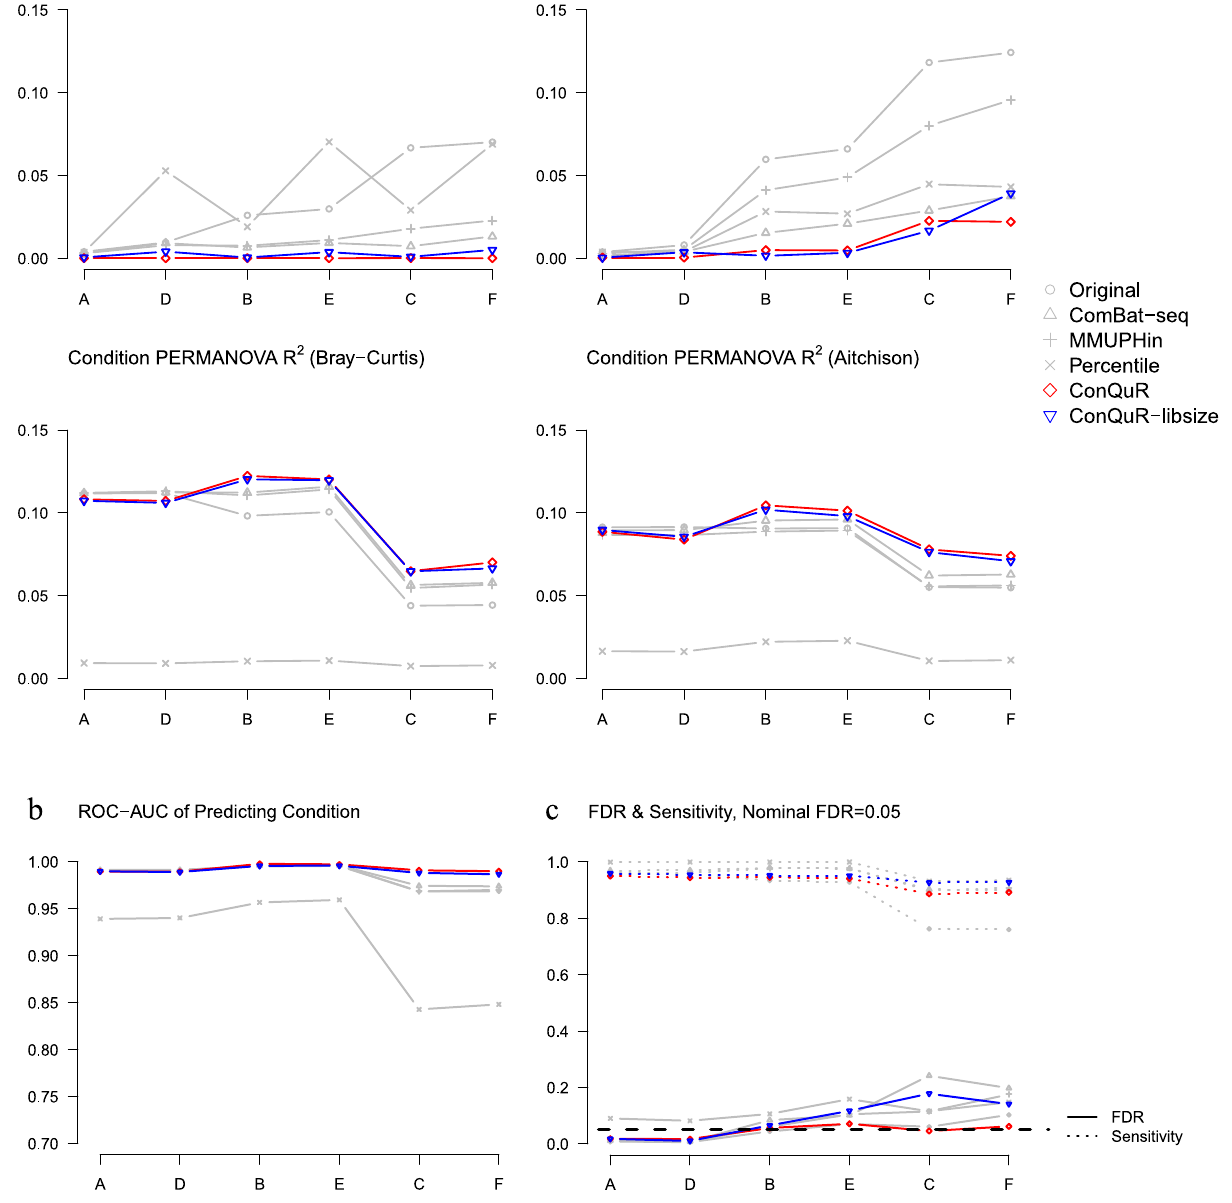
Fig. 2 |Evaluationonthesimulateddata. Thereare6 simulationscenarios with2 corresponding method are shown on the right within the graph. a Average pro- conditions and 2 batches, based on the starting data processed from the MOMS-PI portions of data variability explained by Batch and Condition, quanti fi ed by study. Simulation scenarios are: A. Condition FC=16, Batch FC=1 (Null), B. Con- dition FC=64, Batch FC=4 (Condition Effect>Batch Effect), C. Condition FC=4, Batch FC=64 (Condition Effect<Batch Effect), where Condition and Batch are simulated from joint Bernoulli distribution with p Condition =0.5, p Batch =0.5, and OR=1.25; Scenarios D, E, F are similar to Scenarios A, B, C, respectively, but , making batchvariability incorporate librarysize variability. In p Batch = 1 1+exp (cid:1) libsize s ð Þ thefollowingplots,thescenariosarearrangedonthex-axiswiththeorderA,D,B,E, C, F because the two Nulls are allocated together, followed by Condition Effect> Batch Effect, and then Condition Effect<Batch Effect. Color and the name of the